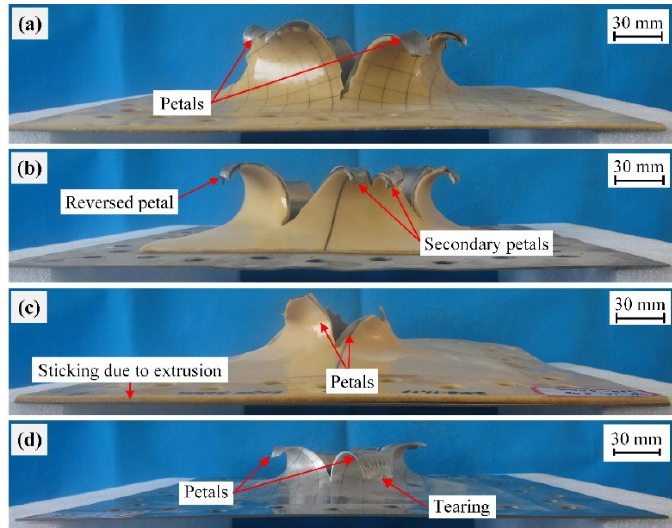
Figure 6. Photographs of the damaged plates ( a ) SPW-1, ( b ) SPP-1, ( c ) SPC-1, and ( d ) BS-1 (from Ref. [47]) tested at a stand-o ff distance of 50 mm.